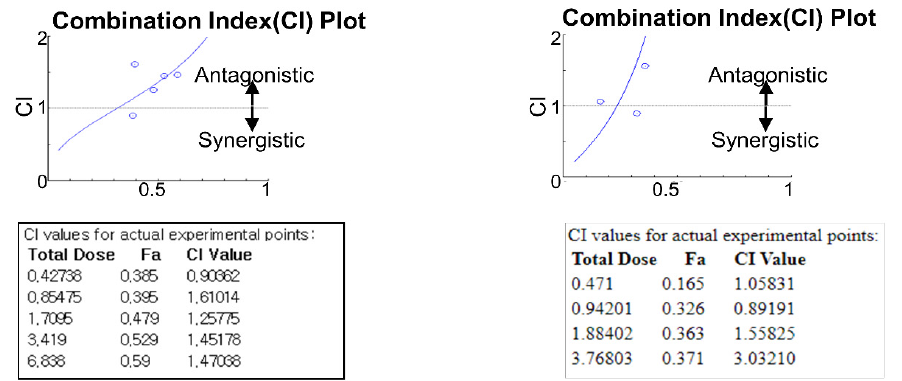
Figure 2. Sequential eribulin and abemaciclib treatment results in enhanced cell growth inhibition. ( A ) The viability of palbociclib-sensitive HR-positive cells (MCF7 and T47D), palbociclib-resistant HR-positive cells (MCF7-PR and T47D-PR), and TNBC (MDA-MB-231) cells after eribulin or abemaciclib treatment at different concentrations for 48 h were assessed by MTT. IC50 values were calculated using CompuSyn. The data represent the mean ± standard deviation of four repli- cates. ( B ) Cells were treated with increasing concentrations of eribulin and abemaciclib combinations at a fixed ratio for 48 h. Eribulin was given first, and abemaciclib was then given sequentially without a time gap, and cell viability was determined by MTT assay. ( C ) Cells were treated with increasing concentrations of eribulin and abemaciclib combinations at a fixed ratio for 48 h. Both drugs were given simultaneously, and the cell viability was determined by MTT assay. The CI was calculated by the Chou–Talalay method. CI < 1, CI > 1, and CI = 1 indicate synergism, antagonism, and additive effect, respectively. HR Hormone receptor, TNBC triple-negative breast cancer.